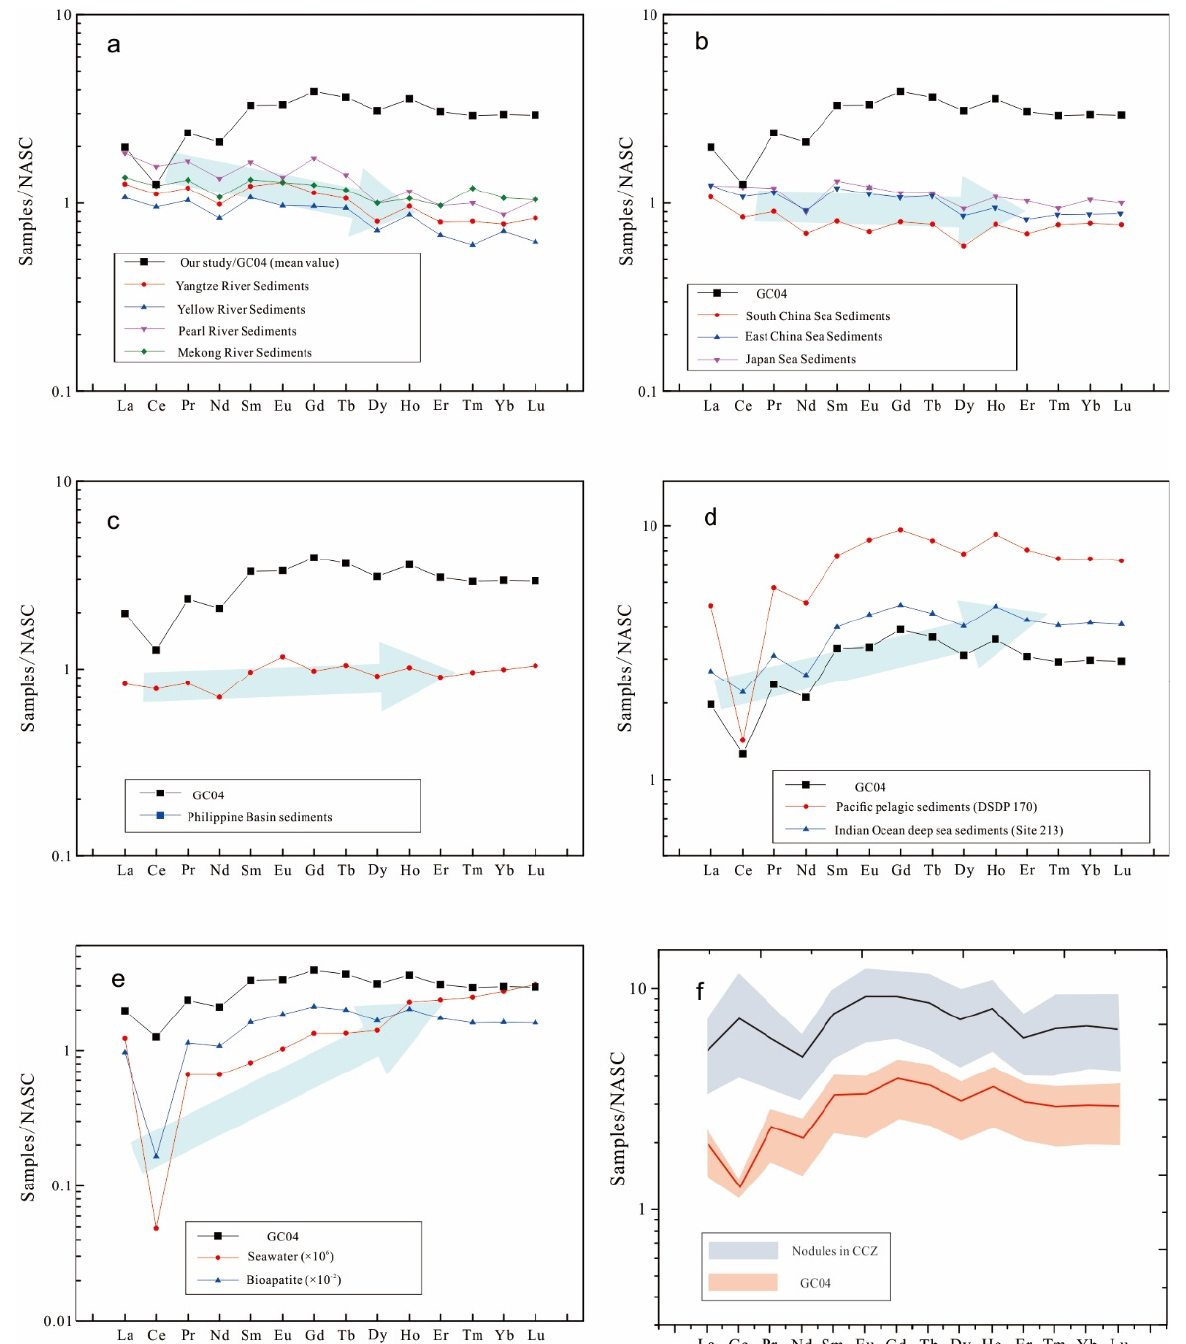
Figure 9. The NASC-normalized REE patterns in our study and comparison with other geological bodies, all the REE values of geological bodies are averaged. ( a ) Yangtze River sediments data are from [61], Yellow River sediments data are from [61], Pearl River sediments data are from [62], Mekong River sediments data are from [61]; ( b ) South China Sea sediments data are from [63], East China Sea sediments data are from [20], Japan Sea sediments data are from [64]; ( c ) Philippine Basin sediments data are from [65]; ( d ) Pacific pelagic sediments data are from [66], Indian Ocean deep-sea sediments data (Site 213) are from [36]; ( e ) the seawater values are given by [59], bioapatite data are from [67]; ( f ) Polymetallic nodules data in CCZ are from [28], the black line and red line represent the average value of nodules and GC04